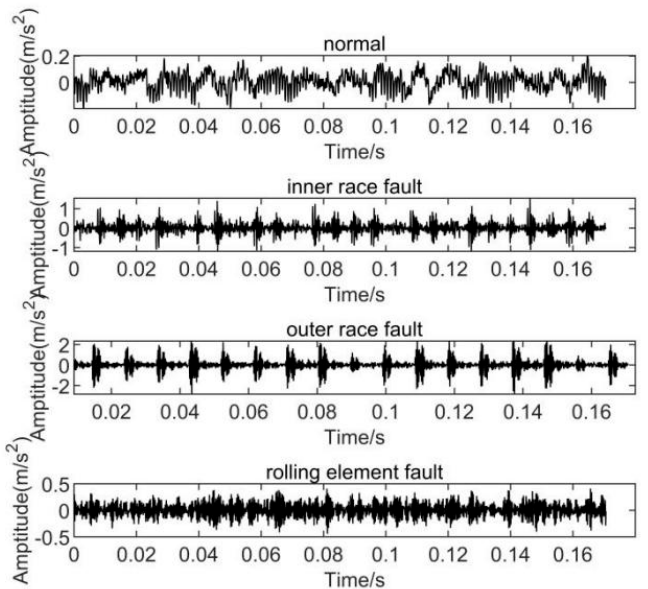
Table 1. A description of the bearing dataset.